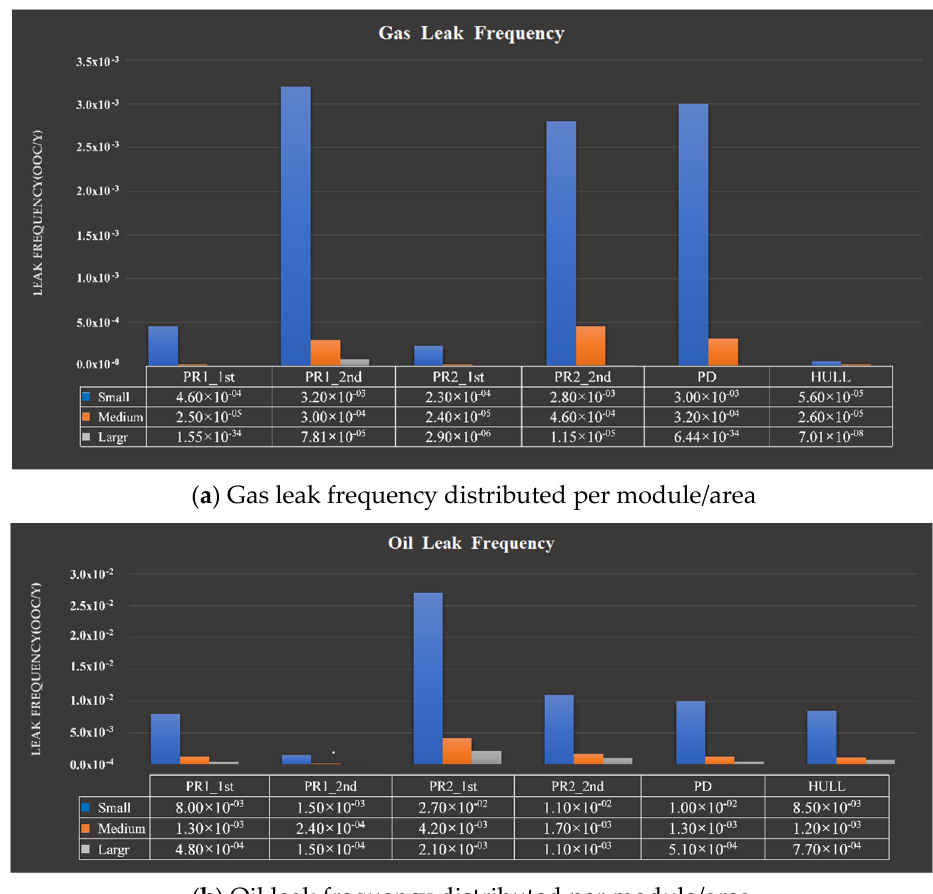
Figure 6. Regions defined for probabilistic explosion and fire analysis.(a) shows the process deck region with process module and deck, offloading starboard and portside, firewall, power-genera- tion module, electrical module, utility module, living quarter, helideck, base of flare tower, crane portside and starboard; (b) shows the hull deck region with closed drain area, flare KO drum area and risers.